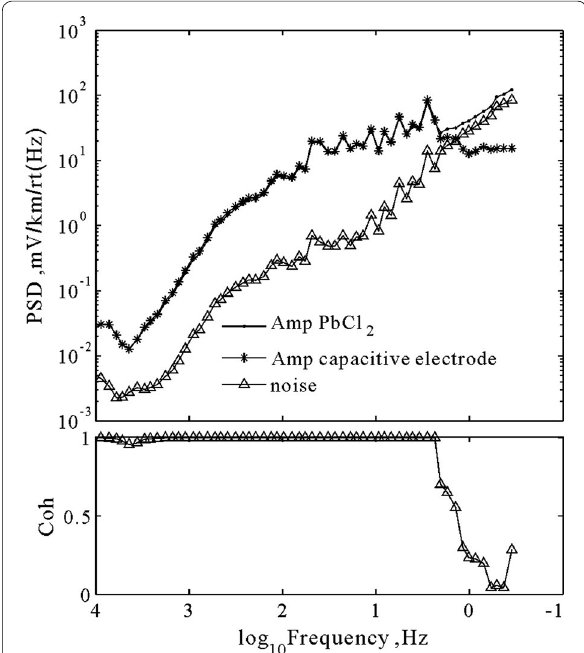
Fig. 11 Results of the noise parallel (NPI) test. From 10 kHz to 3 Hz, the E-field signals measured by the two types of electrodes show high homogeneity. The coherence is high above 3 Hz. Below 3 Hz, the difference in the power spectrum density (PSD) is larger and the coherence decreases. Because the signal to noise ratio (SNR) in the low-frequency bands is low, the data quality decreases. The coher- ence of the two types of electrodes is approximately 1, with a fluctua- tion less than 5% when the frequency ranges from 3 Hz to 10 kHz